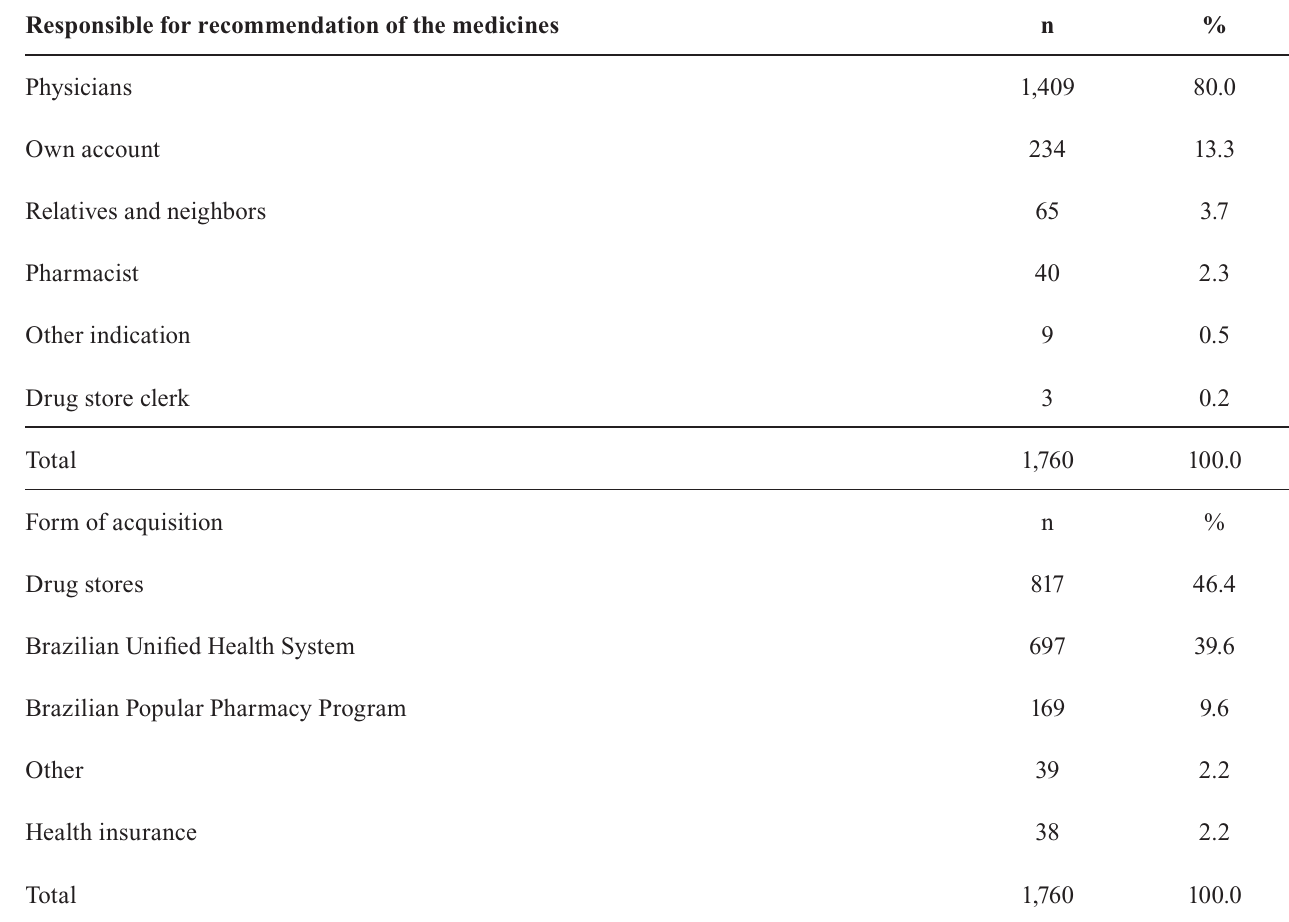
TABLE III - Responsible for recommendation and form of acquisition of the medicines used in the 15 days prior to data collection, Metropolitan Region of Manaus, 2015 (n=1,760